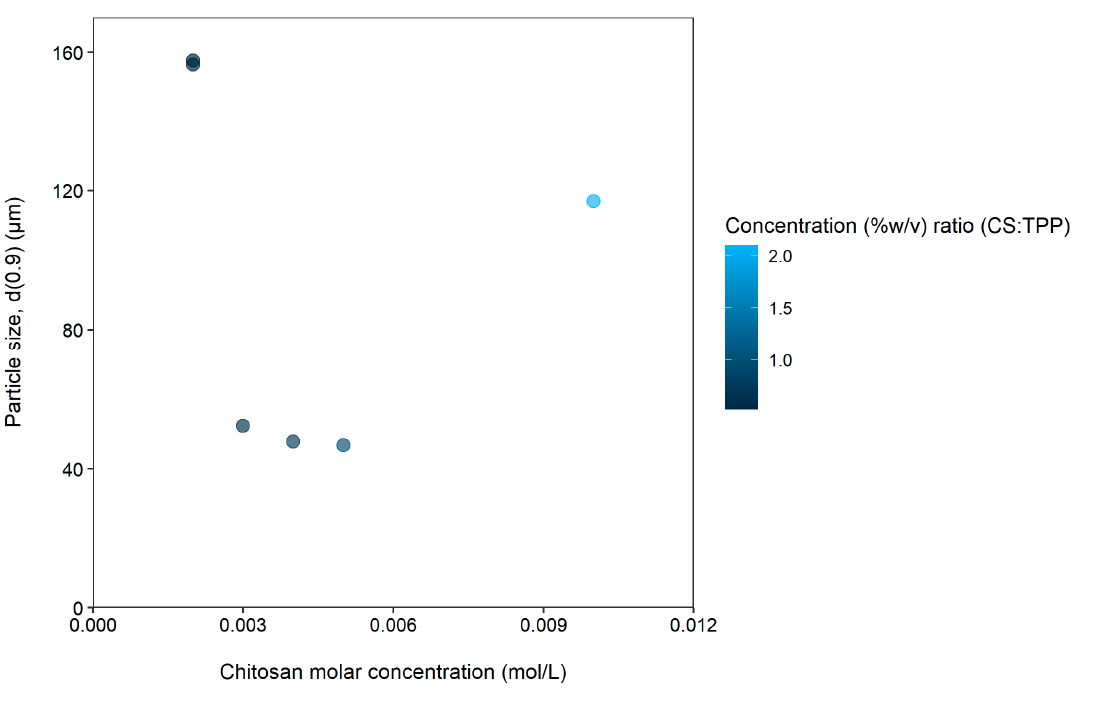
Figure 2. The particle size (d(0.9)) plotted as a function of chitosan molar concentration at a fixed tripolyphosphate concentration of 0.006 mol/L. The chitosan (CS):tripolyphosphate (TPP) concentration (% w / v ) ratios are also indicated by color intensity of the markers.